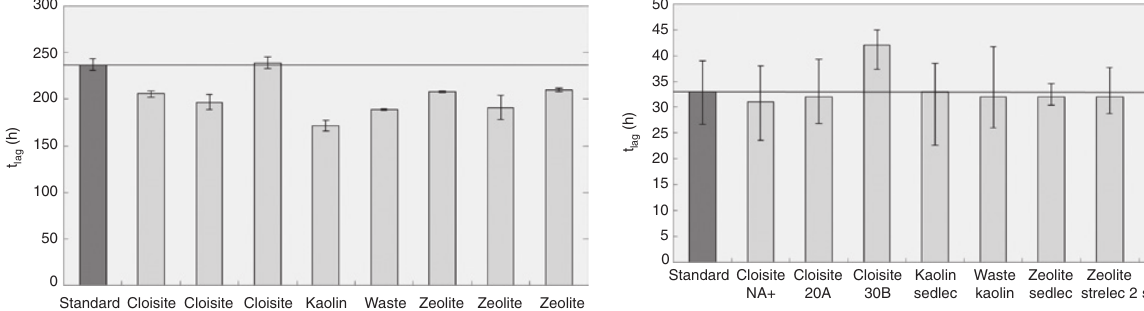
Figure 8: The lag phase during the PVA 72-10 biodegradation with no adapted inoculum in the presence of the selected group of clay minerals ( ± standard deviation).